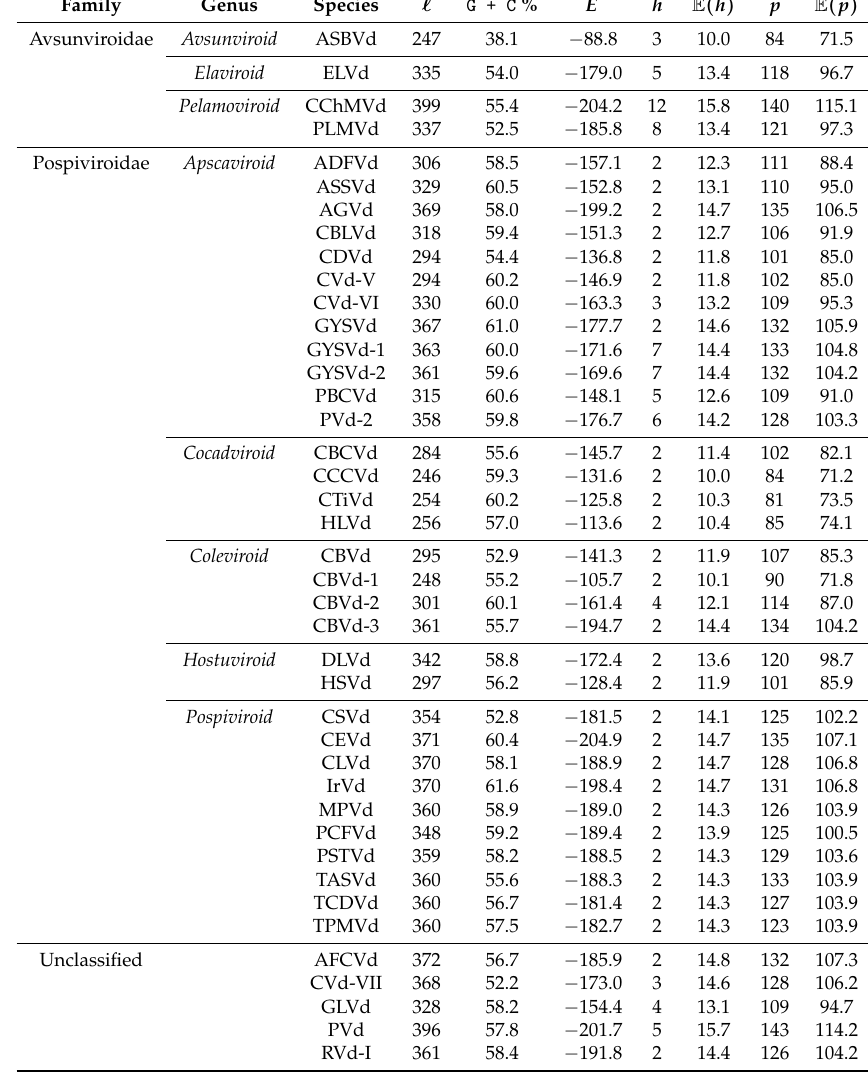
Table 1. Structural properties of viroids of length (cid:96) . We list their G + C content, the minimal folding energy E in kcal mol − 1 (see Materials and Methods), and the number h of hairpins and p of base pairs. For comparison, the expected values of the number of hairpins, E ( h ) , and base pairs, E ( p ) , in exact calculations of structures of each length (cf. Equation (6)) are reported along the actual